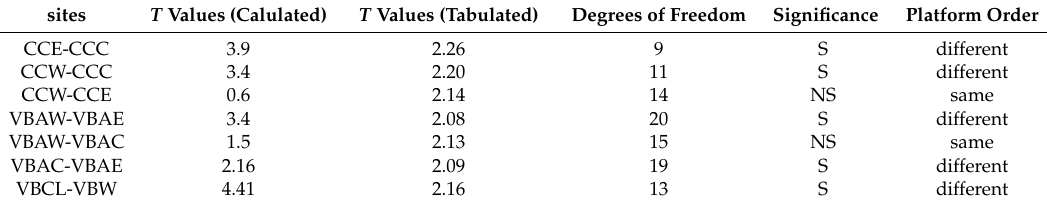
Table 1. T ‐ test results for differences between different platform orders within the same localities. Site codes contains the indication of the locality (CC—Castell Cirlo, VB—Villa Baldini, VBE—Villa Beatrice) and the position of the site within the locality (E—eastern, C—central, W—western). sites Degrees of